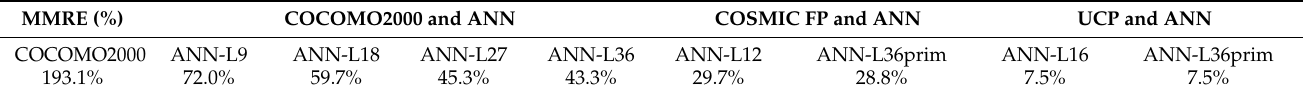
Figure 9. Influence of dependent variables (UUCP and AUCP) on the change in the MMRE value. By comparing the results of the parametric method COCOMO2000 with improved COCOMO2000 and ANN, it can be concluded that the model error is reduced by 193.1/43.3 = 4.5 times. In the second proposed approach, comparing the parametric method COCOMO2000 and the improved COSMIC FP and ANN, the model error reduction is 193.1/28.8 = 6.7 times. Compared with the COCOMO2000 parametric method with UCP and ANN, the model error reduction is 193.1/7.5 = 25.7 times (Table 12; Figure 10). In the first proposed approach, the lowest model error value is 43.3% for the ANN-L36 architecture. In the second proposed approach, the lowest error value is achieved with ANN-L36prim, with a value of 28.8%. In the third proposed approach, both proposed architectures, ANN-L16 and ANN-L36prim, give the lowest model error value of 7.5% (Table 12; Figure 10). It can be concluded that the third proposed UCP approach achieves the lowest MMRE value. In addition, the ANN-L16 architecture in this approach converges rapidly and reaches the “stop criterion” after the fourth iteration, which is also the lowest number of repeated iterations that apply to all architectures used in all three proposed approaches. The influence of dependent variables on the change of MMRE values in the ANN-L16 architecture is less than 0.5%. It can be concluded that the improved UCP model using the ANN-L16 architecture is the best-proposed estimate of effort and cost for software project development. Table 12. MMRE values for the approaches used.